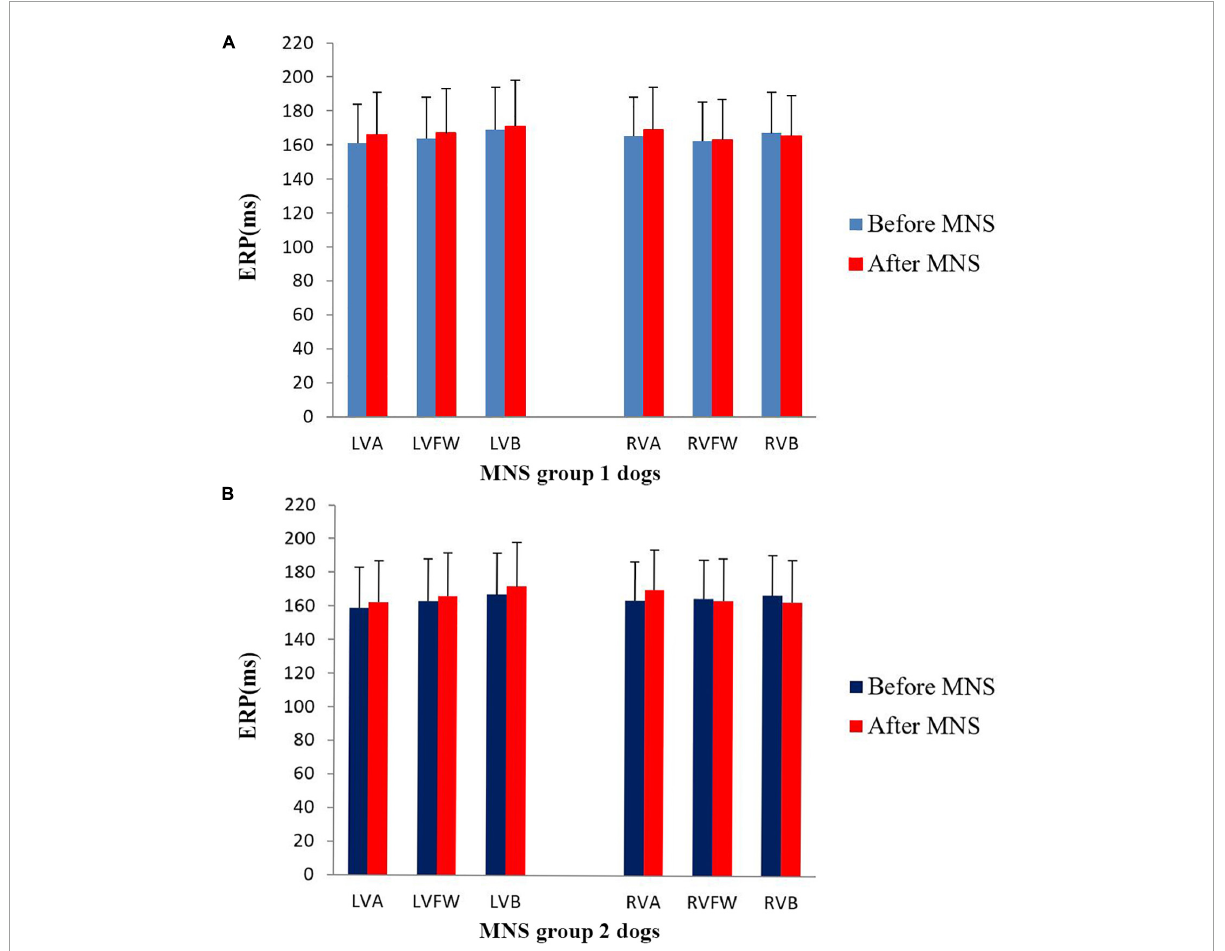
FIGURE5 Changes in the ventricular effective refractory period (ERP) before and after median nerve stimulation. (A) MNS group 1 and (B) MNS group 2. No significant difference in the ERP before and after MNS in the MNS group 1 and MNS group 2 dogs. MSN, median nerve